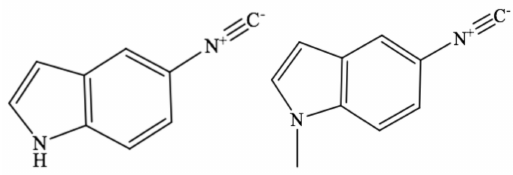
Figure 1. Structures of ( a ) 5-isocyano-1H-indole (5ICI) and ( b ) 5-isocyano-1-methyl-1H-indole